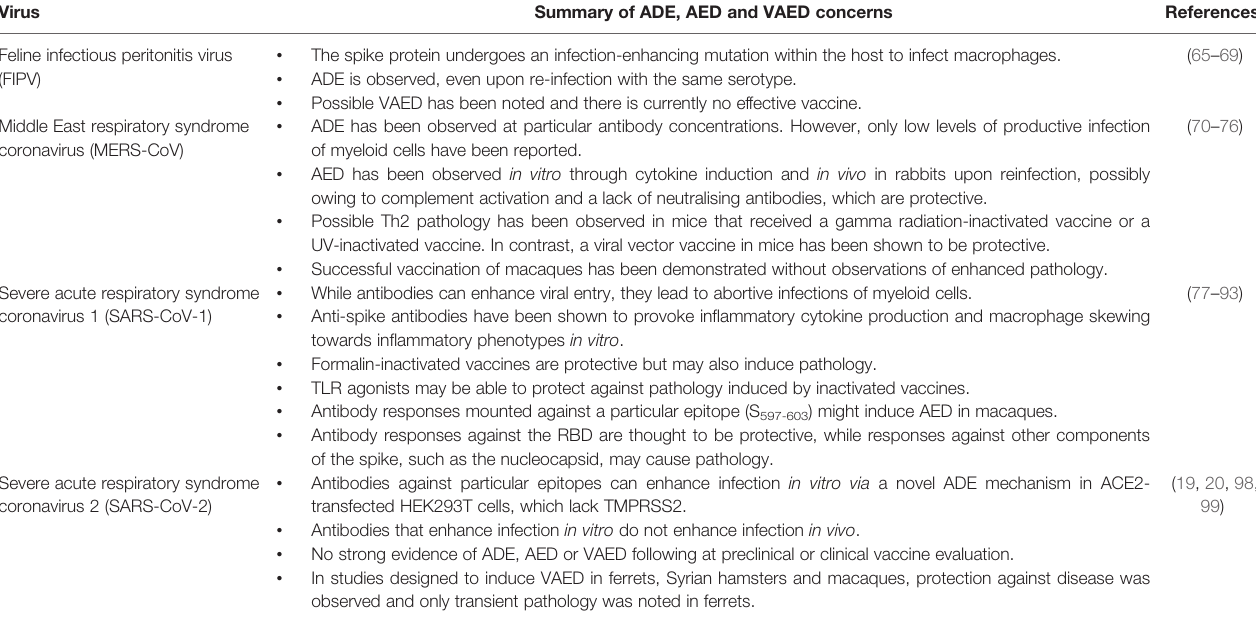
TABLE 2 | An overview of ADE, AED and VAED concerns in pathogenic coronaviruses. Virus Summary of ADE, AED and VAED concerns Feline infectious peritonitis virus